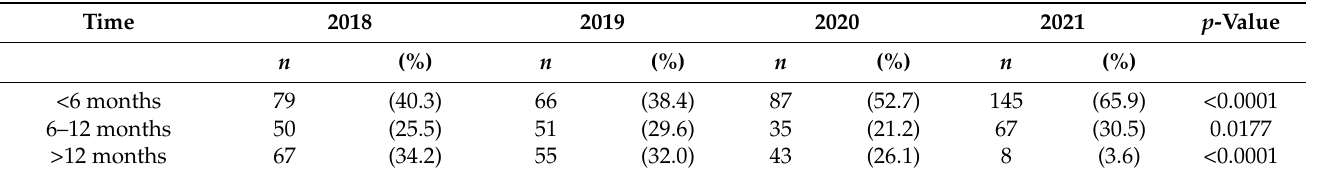
Table 4. Actual survival for patients referred to SCOC according to the year (2018–2021).